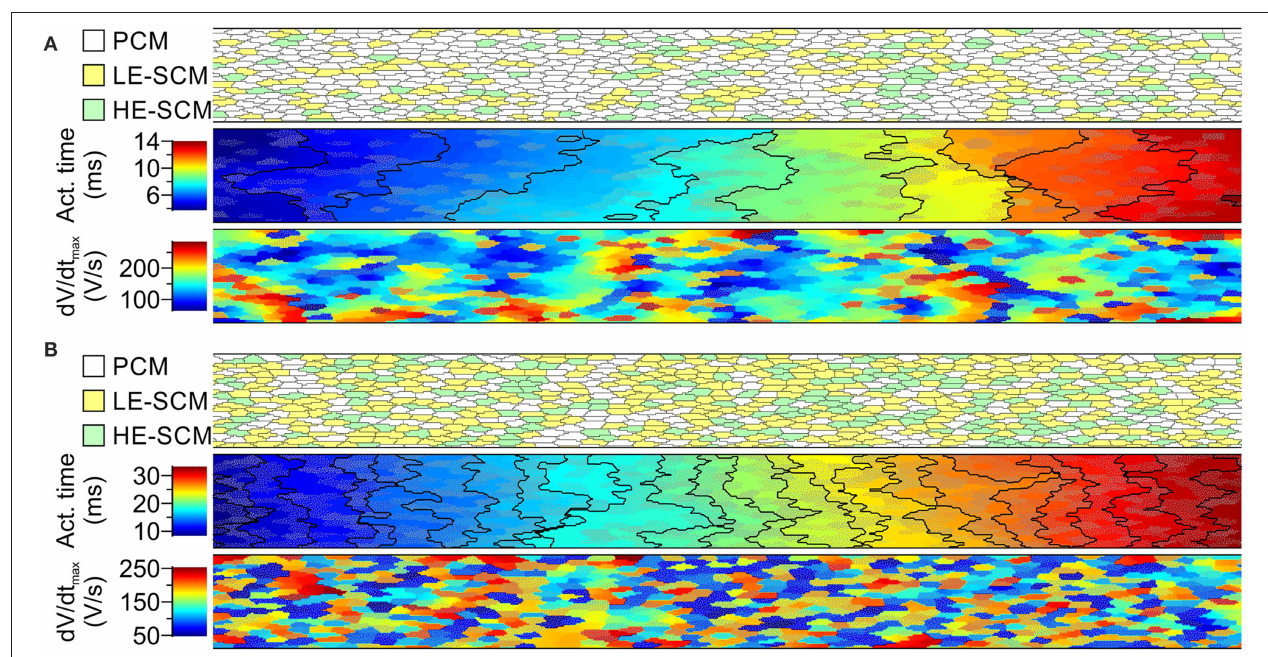
FIGURE 5 | Simulations of action potential propagation in randomly generated strands combining PCMs and SCMs in proportions of 2/3 PCMs and 1/3 SCMs (A) and 1/3 PCMs and 2/3 SCMs (B). Each panel shows a map of cellular architecture (top), the corresponding activation map with isochrones (interval: 1ms) and the map of dV/dt max . The SCMs were distributed randomly with a ratio of 2:1 between SCMs with low and high excitability. SCMs are shown in color (yellow/green) or with an overlaid dotted texture. Overall conduction velocities: 17.7cm/s in (A ) 7.0cm/s in (B) .